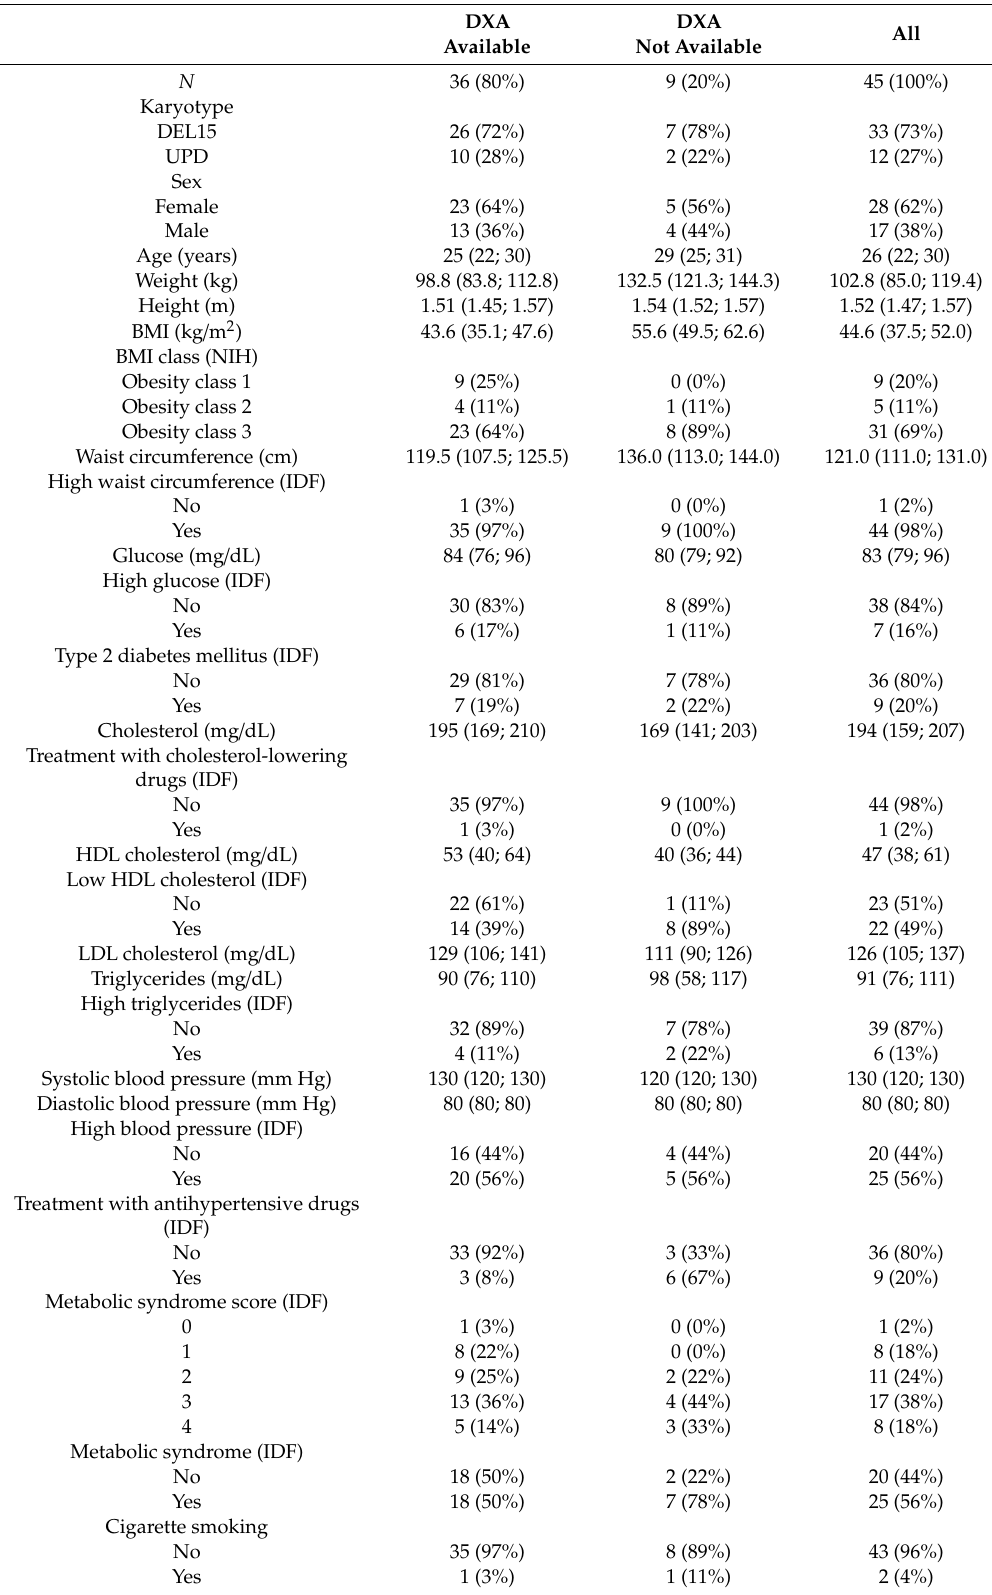
Table 1. Measurements of the Prader–Willi syndrome (PWS) patients at baseline